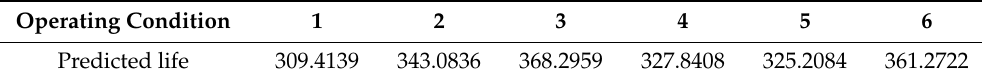
Table 5. The predicted life of each operating condition by similarity trajectory method (STM).